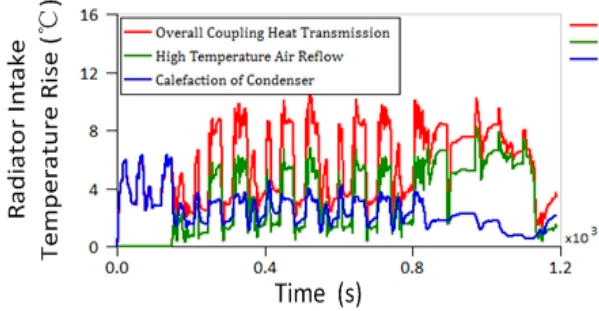
Figure 24. Radiator intake temperature rise caused by the coupling thermal transmission.